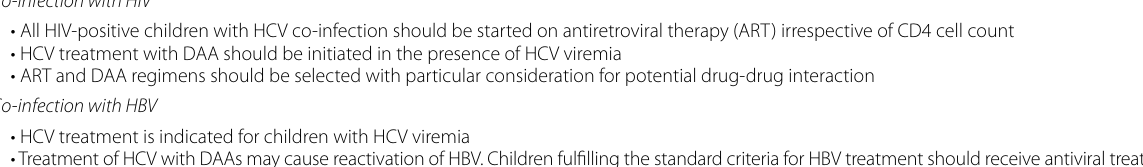
Table 4 Recommendation for the management of hepatitis C in special situations Co-infection with